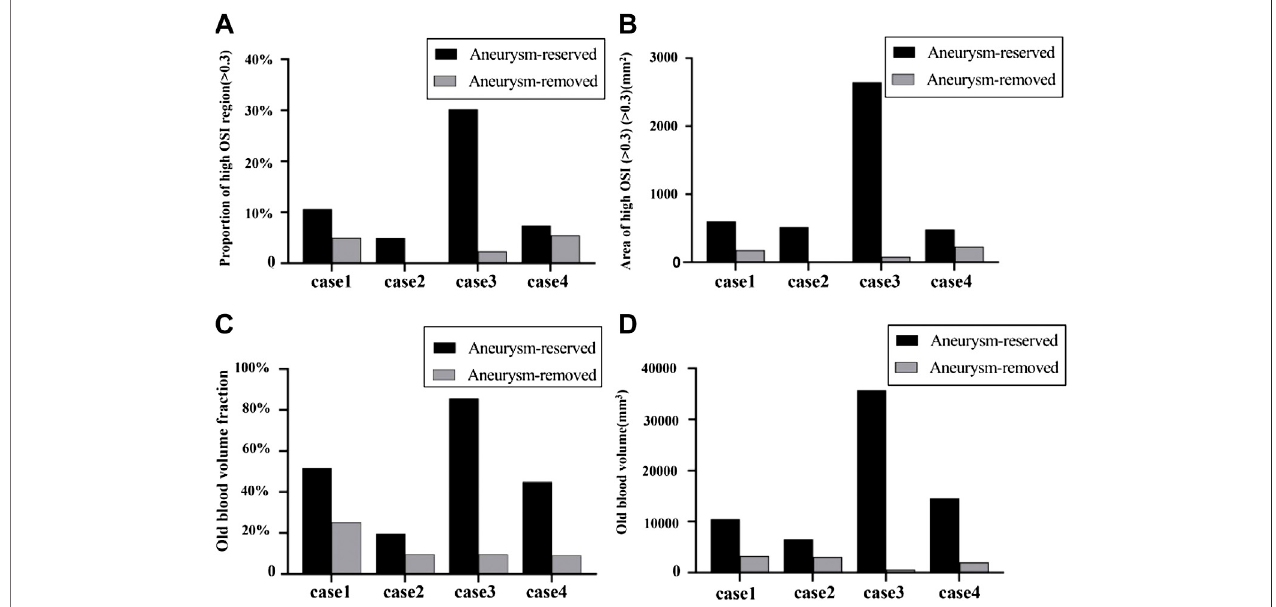
FIGURE 8 | Quantitative comparison between patients and treatments in terms of OSI and blood stasis: (A) proportion of high OSI ( > 0.3) regions; (B) area of high OSI ( > 0.3) for aneurysm-reserved and aneurysm-removed models; (C) OBVF (old blood volume fraction, de fi ned as the ratio of volume of blood residue and volume of the fi stula); (D) OBVs (old blood